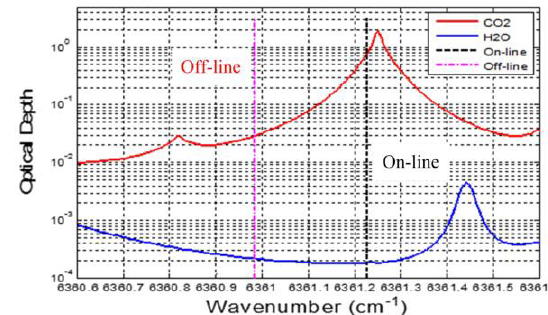
Figure 1 Operation wavelength of the IPDA